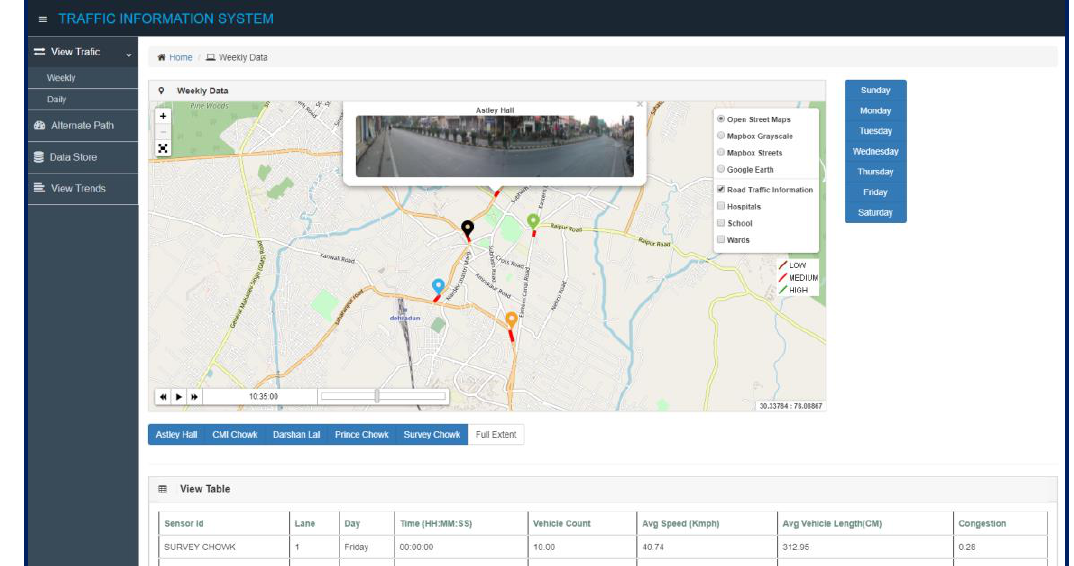
Figure 13. Traffic Information System